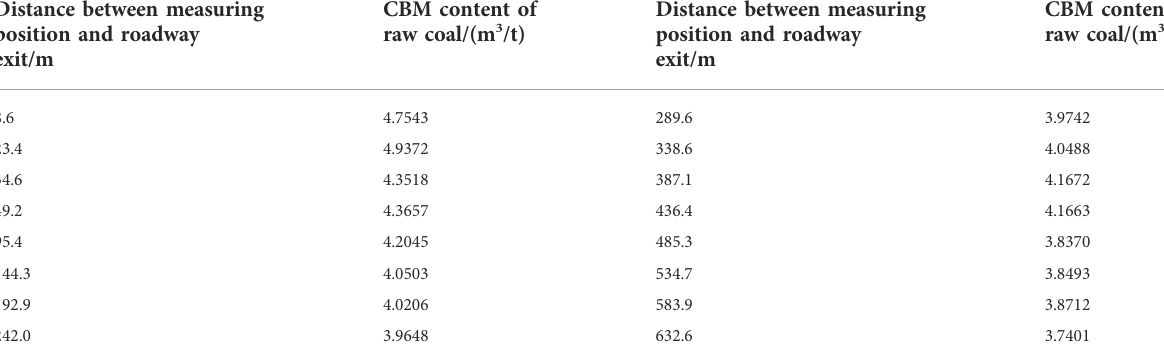
CBM content of raw coal/(m 3 /t)